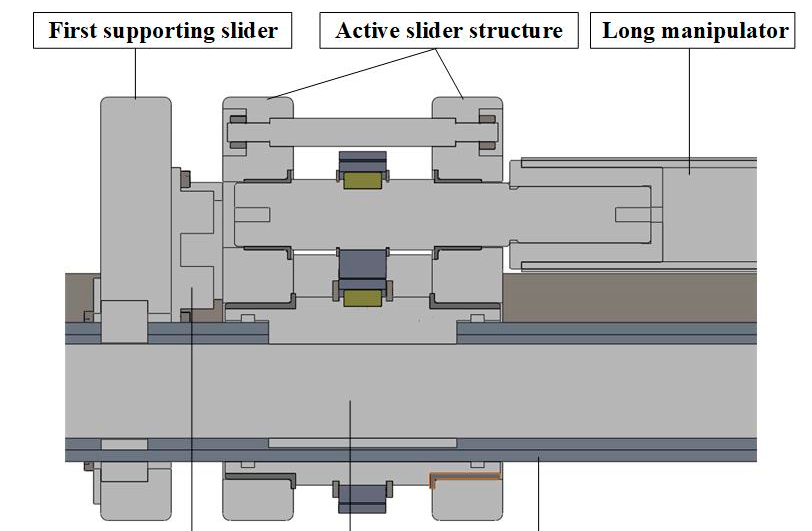
Figure 2. The driving device.